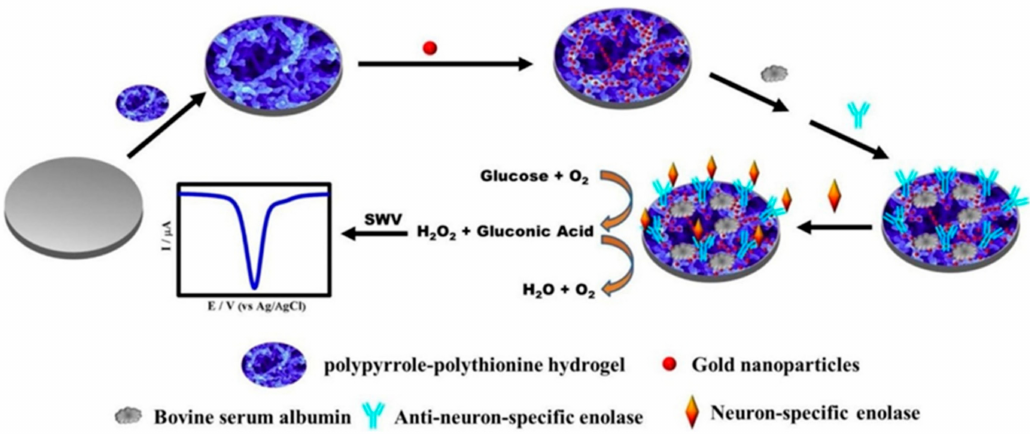
Figure 8. Schematic illustration of synthesized PPy-PT-Au with multifunctional conductive hydrogel for detection of tumor markers (reproduced from [120] with permission, copyright Elsevier,